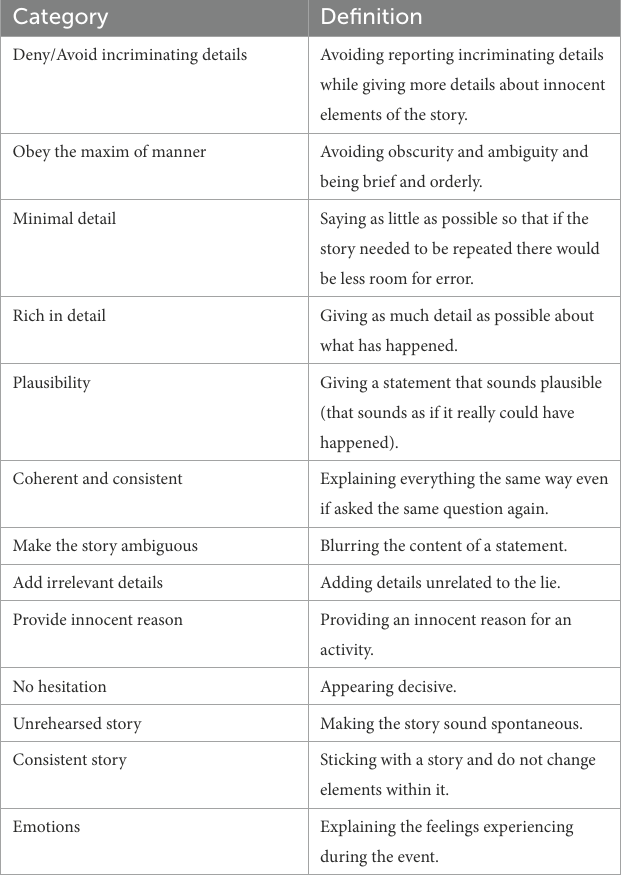
TABLE 1 Verbal strategy categories used when lying and